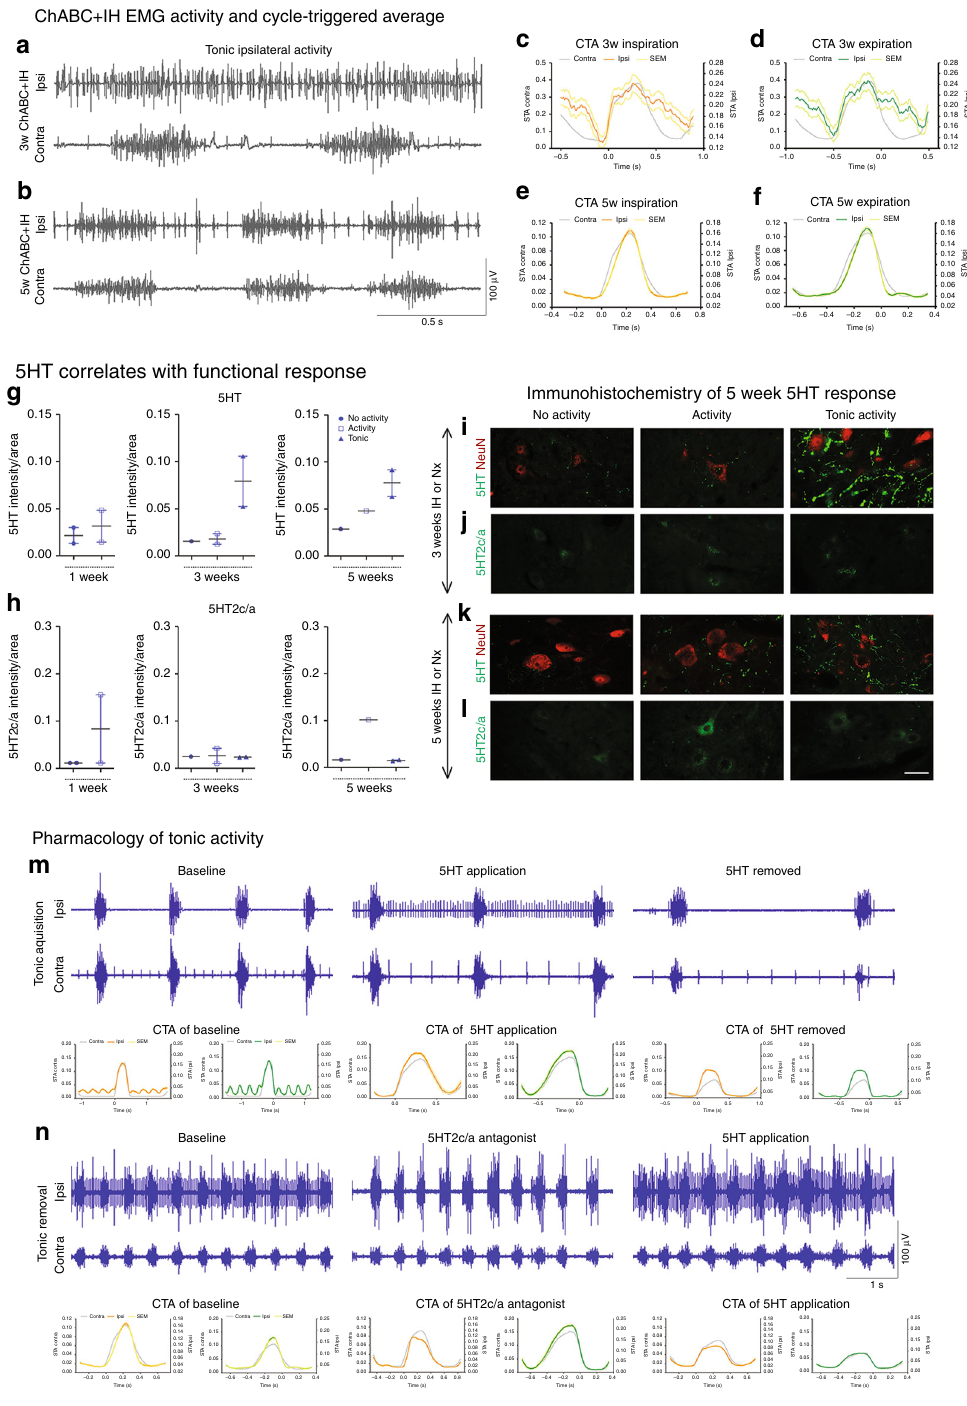
Fig. 4 Excessive 5HT and receptor imbalance causes ipsilateral tonic activity. a – f Tonic diaEMG activity following a 3 or b 5 weeks conditioning. c – f Representative CTAs of ipsilateral (coloured) and contralateral (grey) activity for mean inspiration (orange) and expiration (green) where ±SEM is shown for both inspiration (yellow) and expiration (light green). IH for c , d 3 or e , f 5 weeks ( n = 6, see Fig. 5). g – l Intensity readings for g 5HT, h 5HT2c/a and l representative images at the ipsilateral C4 PMP utilizing i + k NeuN (red) and 5HT (green) or j + l 5HT2c/a (green). Graphs show mean ± SEM. Data grouped on ipsilateral hemidiaphragm activity: non-responders (circle; n = 1/2), normal activity (square; n = 1/2), tonic (triangle; n = 2). m , n Tonic activity following m 5HT ( n = 7) and n 5HT2c/a antagonist ( n = 6) application. CTAs of ipsilateral (coloured) and contralateral (grey) activity for mean inspiration (orange) and expiration (green) where ±SEM is shown for both inspiration (yellow) and expiration (light green) of pharmacologically induced and removed tonic activity. Panels recorded in the same animal. For all EMG or graph panels: animals were treated with ChABC + IH